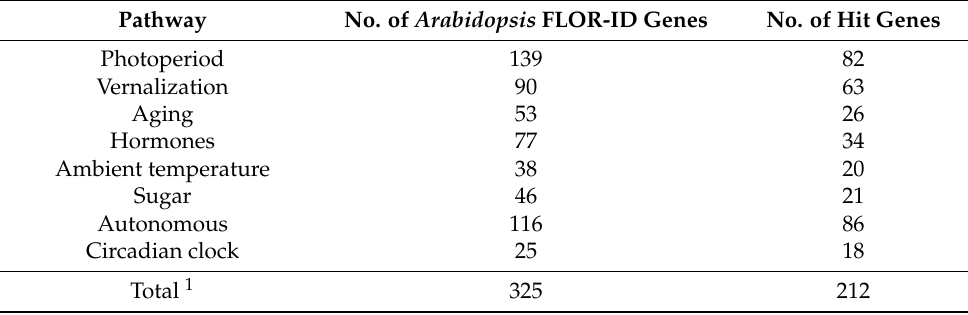
Table 2. Summary of FLOR-ID genes found in gentian